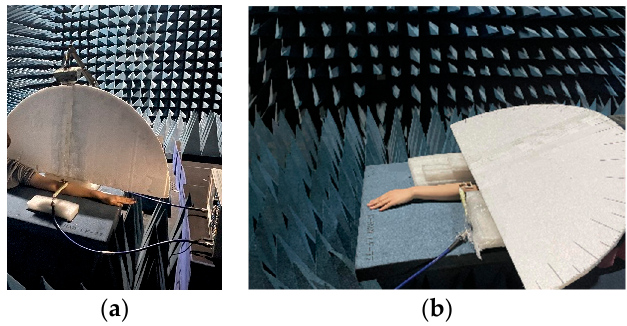
Figure 12. The practical on-arm measurements: ( a ) E plane and ( b ) H plane.